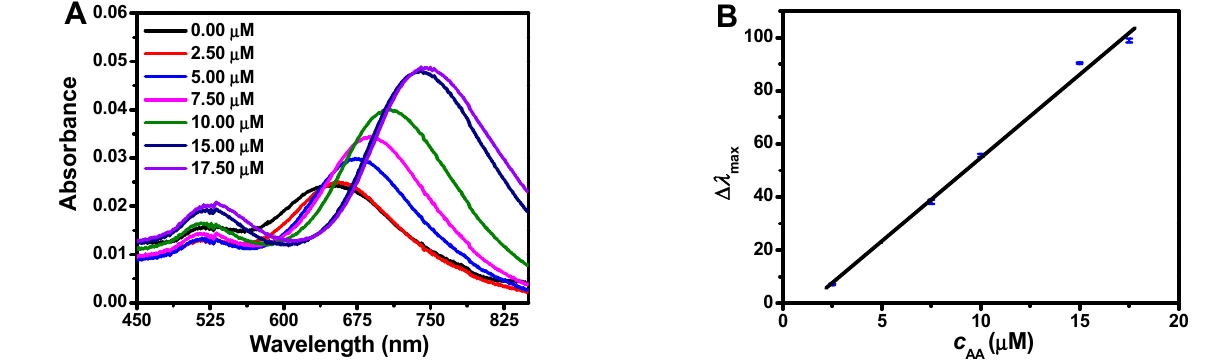
Figure 6 . AA detection based on the red shift of λ max . ( A ) Spectral variations of silver-coated gold nanorods in the presence of different concentrations of AA (from bottom to top: 0 μ M, 2.50 μ M, 5.00 μ M, 7.50 μ M, 10.00 μ M, 15.00 μ M, 17.5 μ M). ( B ) The standard curve for AA detection. Conditions: Au@Ag NRs, 50 μ L; H 2 O 2 , 450 μ M; Fe 2+ ; 0.25 mM; HCl, 0.10 M; t, 25 min; and T, 45 °C.